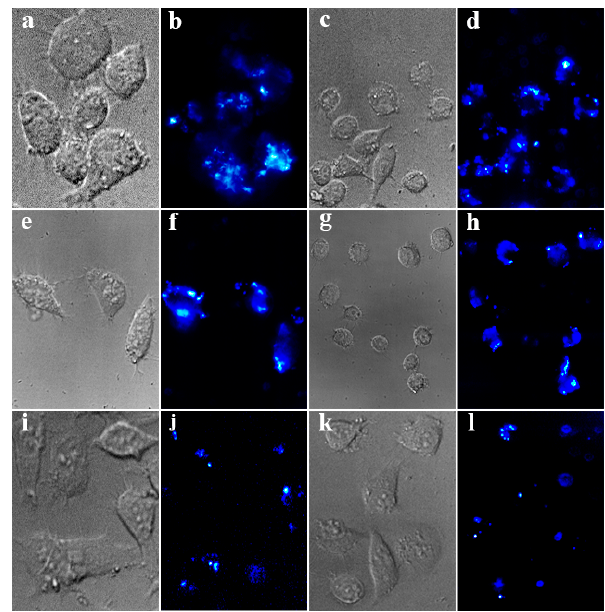
Figure 8. Hela cells were incubated with ( a – d ) NaYF 4 :Tm 3+ /Yb 3+ @MOF-Y:Eu 3+ supernatant, ( e – h